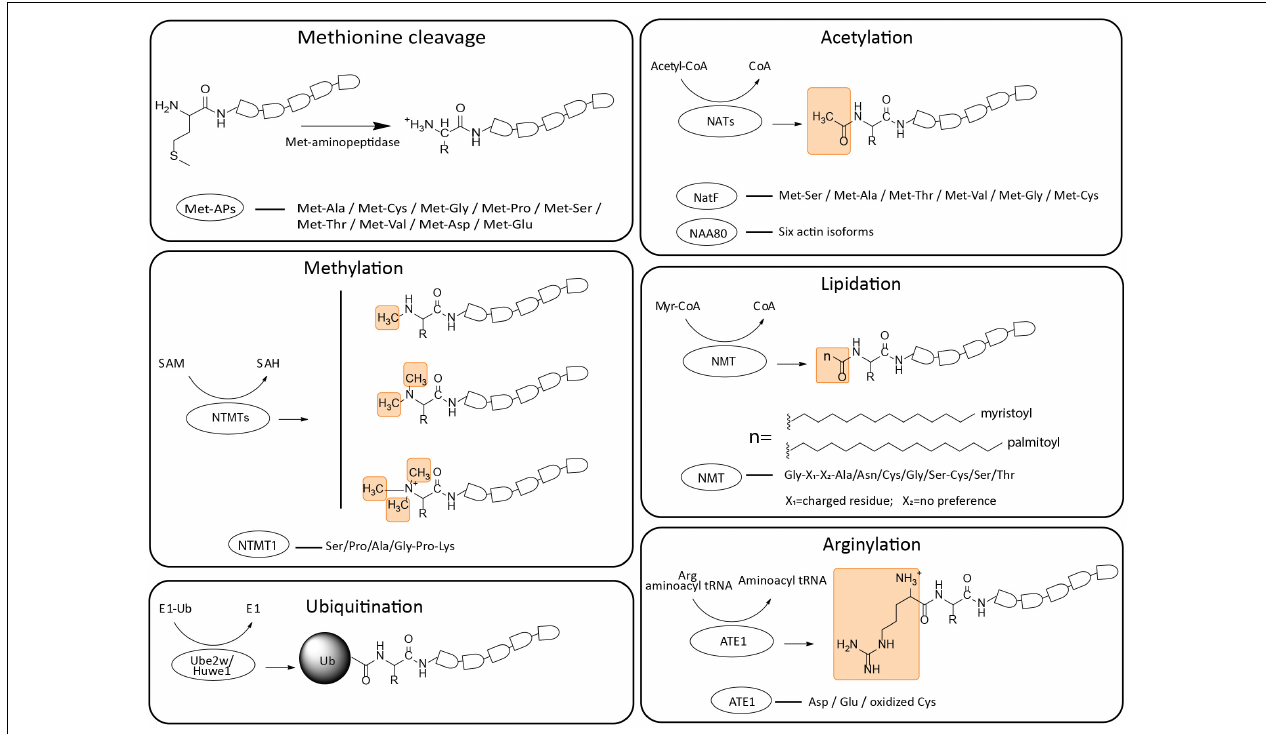
FIGURE 1 | Schematic representation of structural formulas and enzymatic preferences of N-terminal modifications. The PTMs of N-termini include Met cleavage, acetylation, methylation, lipidation, arginylation and ubiquitination (yellow boxes indicate the function groups added to the termini). Corresponding recognition sites of different enzymes are listed. The responsible enzymes and their respective donor molecules are listed. Met-Aps, Met-aminopeptidases; NATs, N-terminal acetyltransferases; NTMTs, N-terminal methyltransferases; NMT, N-terminal myristoyltransferases; ATE1, arginyl transfer enzyme